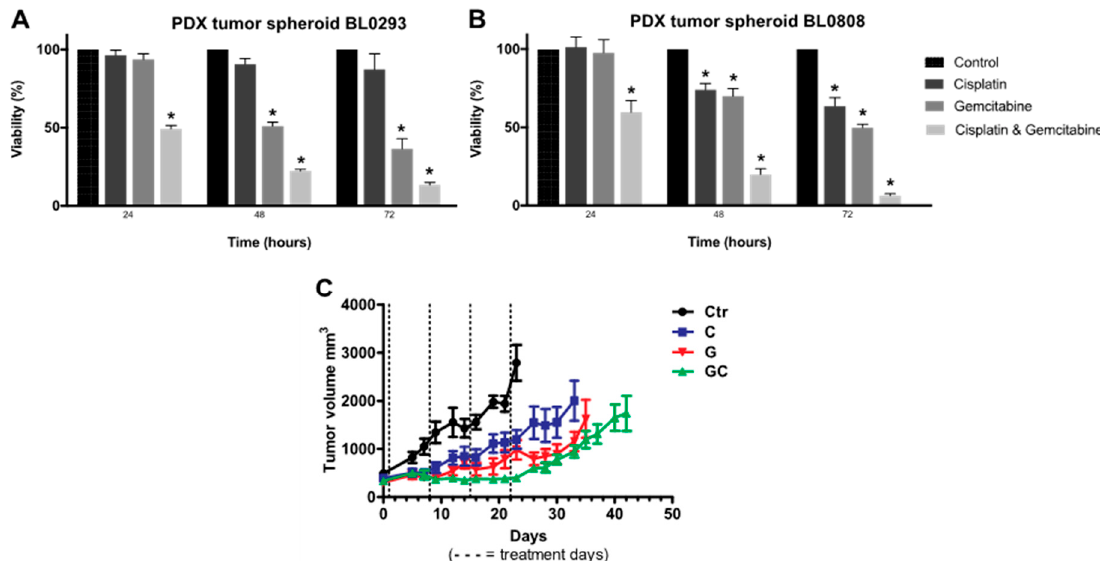
Figure 4. In Vitro drug response. Cell viability of six-day PDX tumor spheroids BL0293 ( A ) and BL0808 ( B ) treated with 10 µ M cisplatin, gemcitabine, and combination thereof for 24, 48, and 72 h. Data displayed as cell viability mean ± SD, referring to two experimental replicates with three technical replicates each ( n = 6). T-student statistical method with * p < 0.01 vs. control. In Vivo drug response: variation of tumor volume for PDX mice BL0808 ( C ). Mice were randomly assigned to the treatment groups and treated with cisplatin at 2 mg / kg (intravenous injection every seven days at 3 doses), gemcitabine at 150 mg / kg (intraperitoneal injection every seven days at 4 doses), or their combination. Data displayed as tumor volume mean ± SEM of a group with six animals ( n = 6).